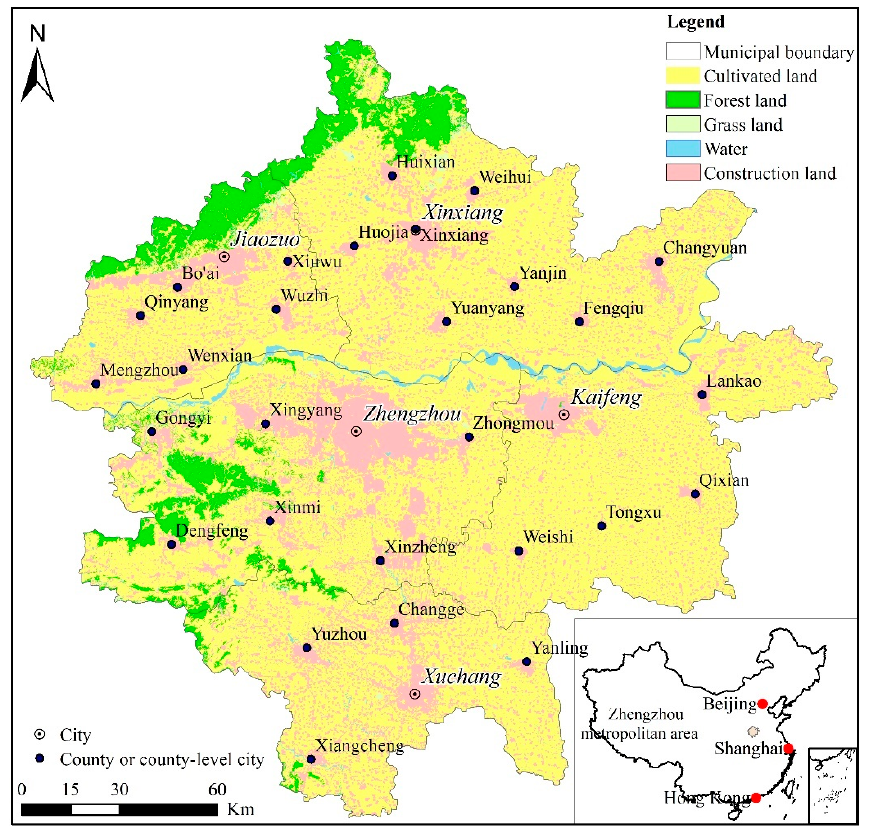
Figure 1. Location and land use of the Zhengzhou metropolitan area.